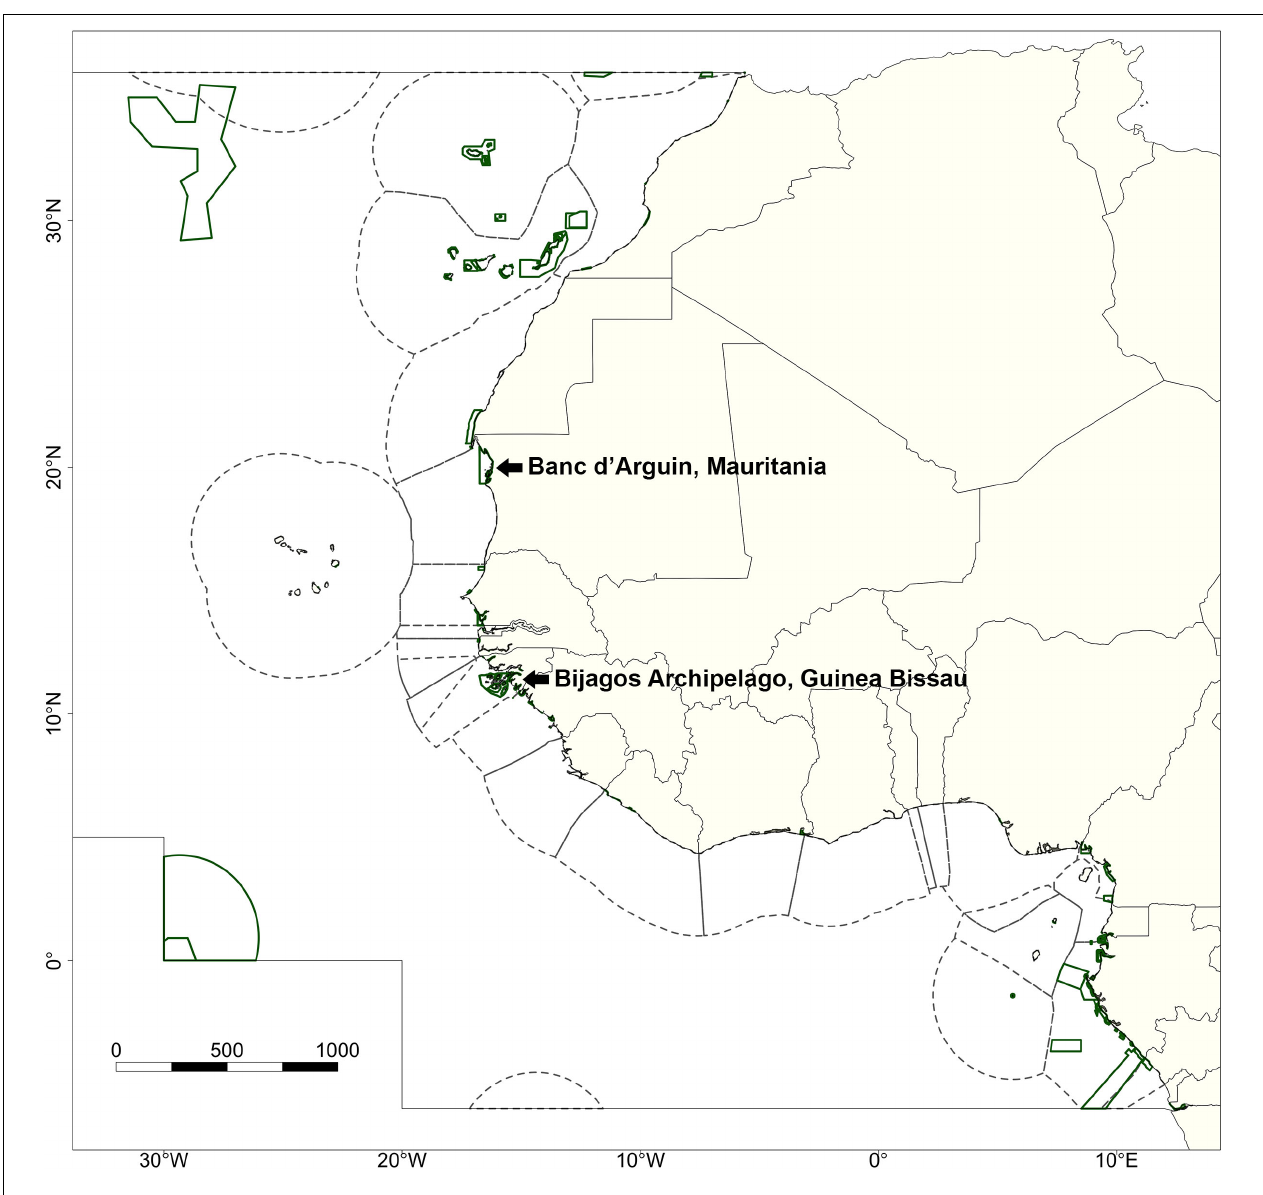
FIGURE 1 | Defined study area indicating the Exclusive Economic Zones (EEZs; dashed lines) and Marine Protected Areas (MPAs; green lines) within the West African region. The inner gray border represents the northern and southern edges of the study area. The two focal MPAs, the Parc National du Banc d’Arguin (Mauritania) and the Bijagós Archipelago (Guinea Bissau), are specifically